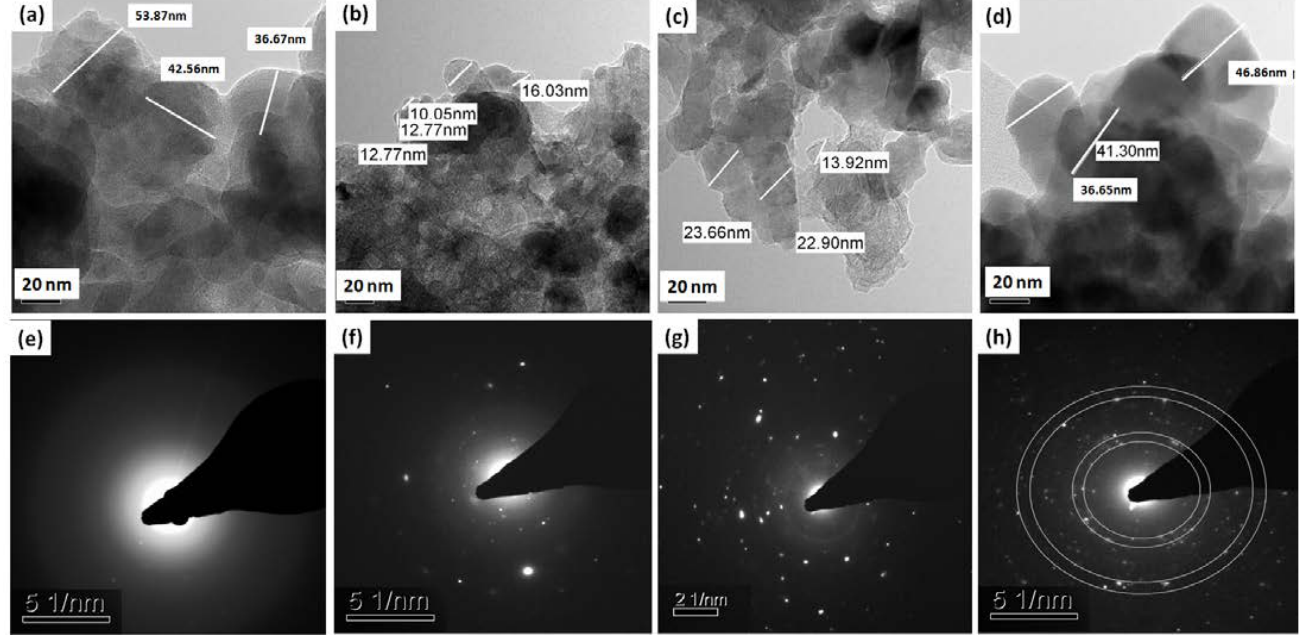
Figure 6. TEM images and corresponding diffraction patterns of ( a , e ) pure MgS, ( b , f ) MgS doped with 3% w/w BaO, ( c , g ) MgS doped with 5% w/w BaO and ( d , h ) MgS doped with 7% w/w BaO.